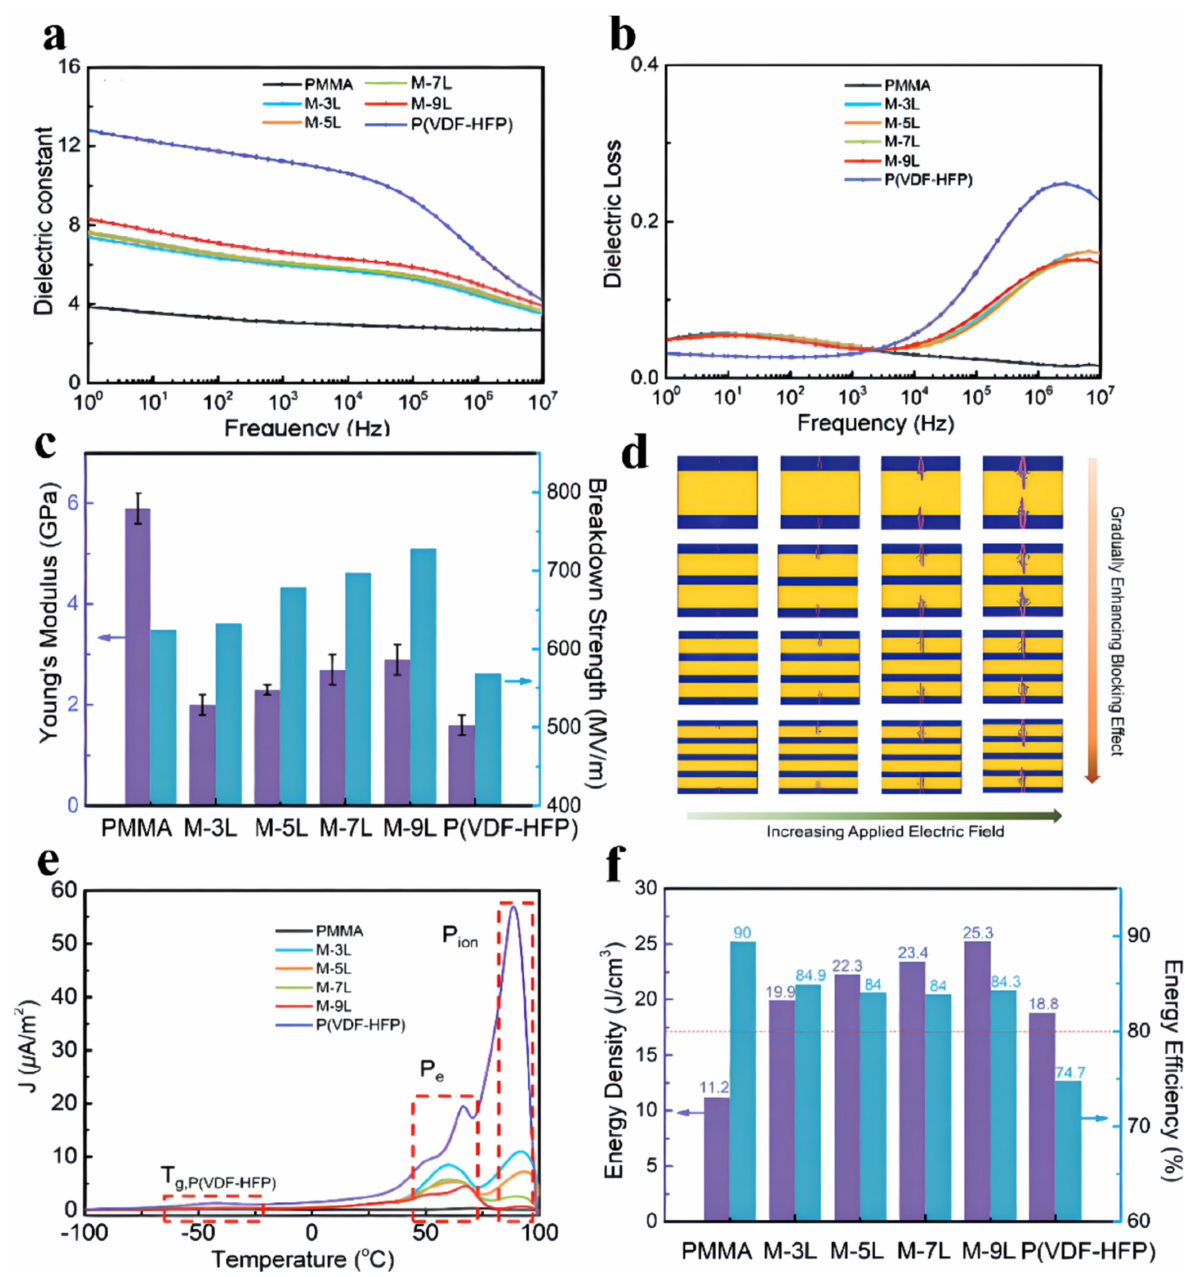
Figure 10. ( a ) Frequency dependence of the dielectric constant and ( b ) dielectric loss for the pure polymer and multilayer composite films. ( c ) Young’s modulus and breakdown strength for the pure polymer and multilayer composite films. ( d ) Breakdown evolution procedures for the multilayer composite films with 3L, 5L, 7L and 9L via phase-field simulation. ( e ) TSDC spectra for the pure polymer and multilayer composite films. ( f ) Comparison of the energy storage properties of the multilayer composite films. Adapted with permission from [45], Copyright © 2022 The Royal Society of